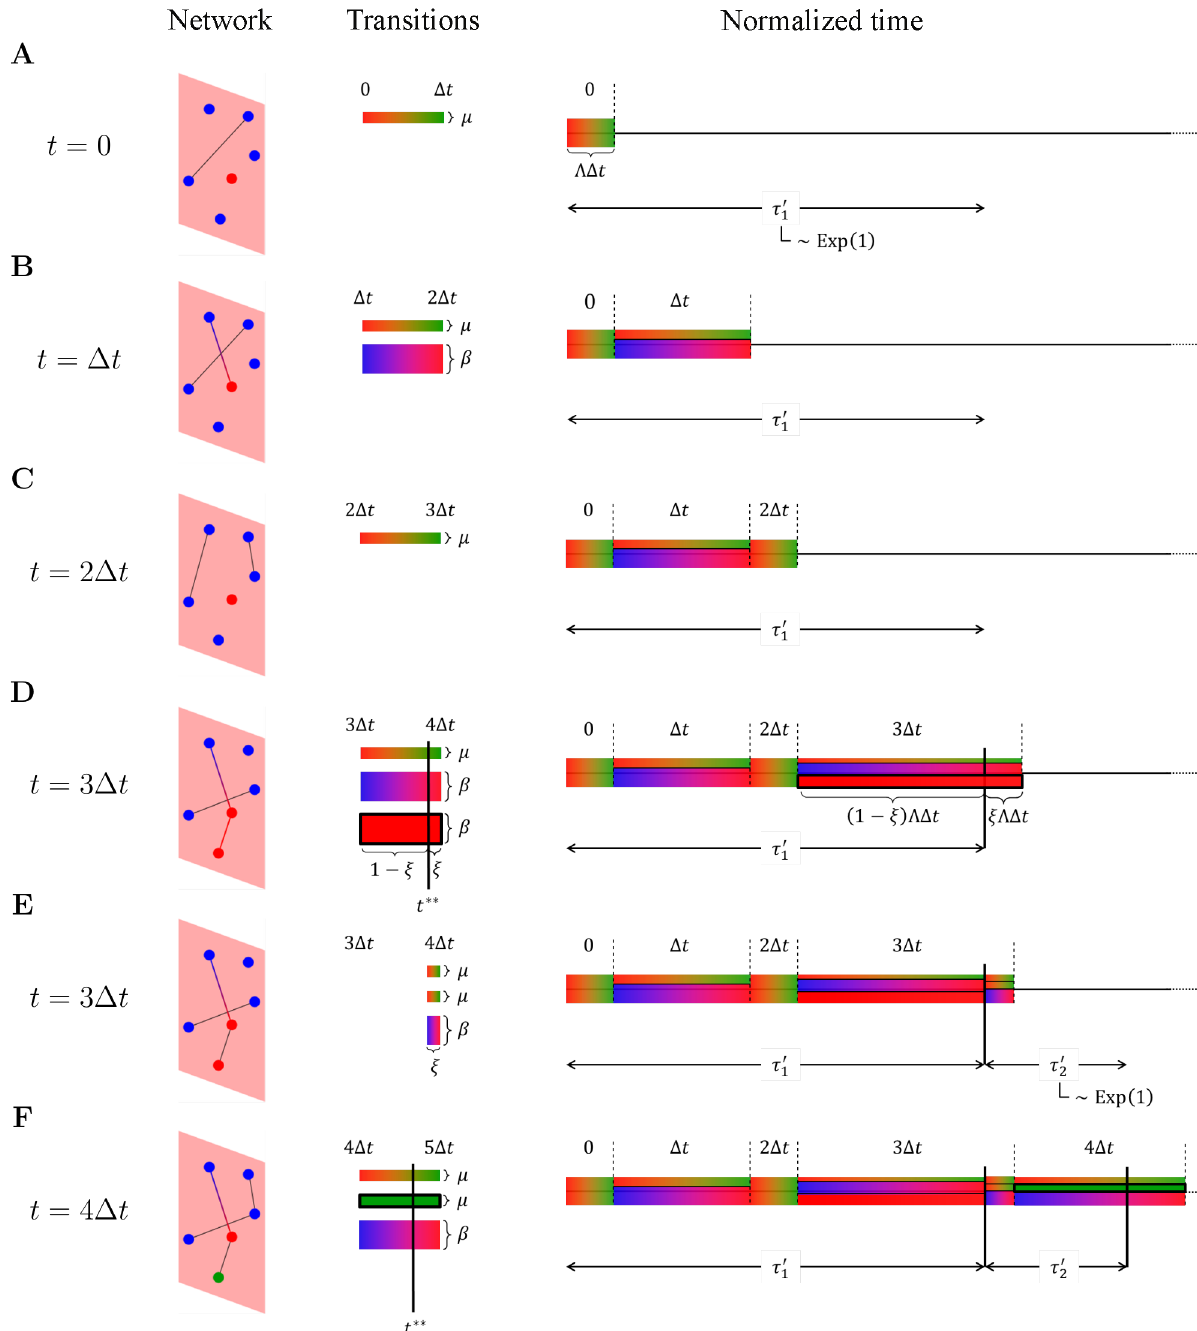
Fig 2. Example of how the temporal Gillespie algorithm works for an SIR process on a time-varying network. We consider the time-varying network of Fig 1A (Network) — time evolves along the vertical axis; a rejection sampling algorithm considers each transition process at each time-step individually (Transitions); the temporal Gillespie algorithm considers the integrated cumulative transition rate of all transition processes, L ð t ;0 Þ , and compares it with the random normalized waiting times t 0 l (Normalized time). A transition takes place whenever L ð t ;0 Þ ¼ works as follows. (A) The fi rst normalized waiting time t 0 1 is drawn from an exponential distribution with unit rate [ t 0 1 (cid:4) Exp ð 1 Þ ] (Normalized time). From the state of the network at the fi rst time-step, the set of possible transitions Ω (0) is found (Transitions), and from this the cumulative transition rate Λ (0) is calculated. The integrated cumulative transition rate, L ð D t ;0 Þ ¼ L ð 0 Þ D t is compared to t 0 1 . If, as in the present example, L ð 0 Þ D t < t 0 1 the algorithm is advanced to the next time-step. (B) and (C) The set of possible transitions Ω ( t n ) and the cumulative transition rate Λ ( t n ) is updated at each following time-step P n (cid:5) 1 ;0 Þ ¼ D t L ð t n ; if L ð t n l Þ is still smaller than t 0 1 , the algorithm is advanced to the next time-step. (D) During the l ¼ 0